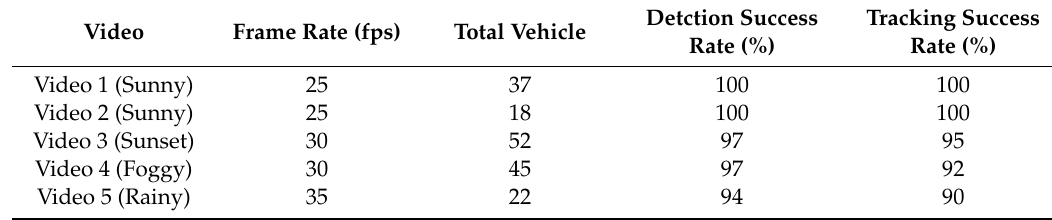
Table 1. Overall system performance.